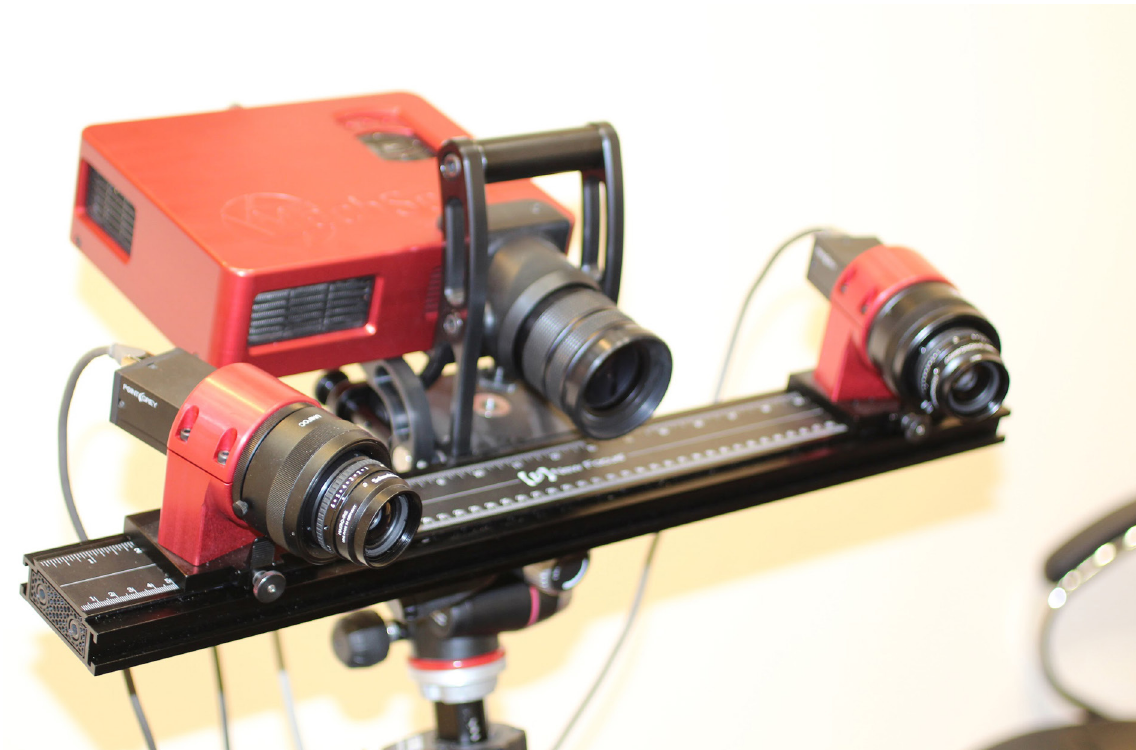
Fig. 3.24. The MechScan white light